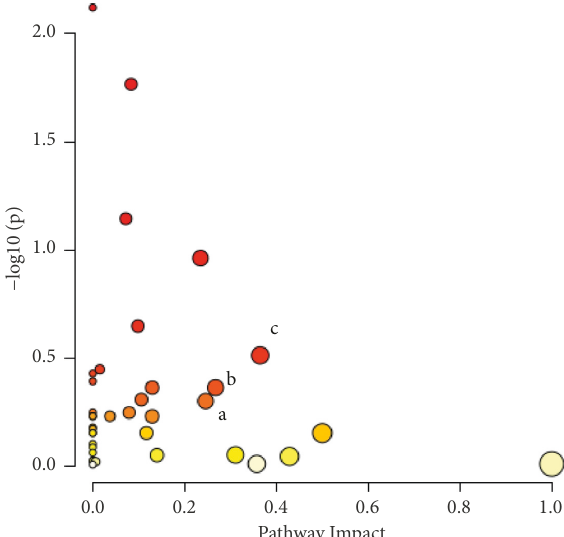
Figure 7: Summary of metabolic analysis conducted using MetaboAnalyst considering the 6 hours after treatment of Pt-EtOMe- SOphen vs. controls. (a) Glycine, serine, and threonine metabolism. (b) Pyruvate metabolism. (c) Glutathione metabolism. Colors, varying from yellow to red, mean that the metabolites are in the data with different levels of significance (yellow: p -value < 0.1; light orange: p -value < 0.05; orange: p -value < 0.01; and red: p -value < 0.001). Circle size, varying from small to big, means the impact of metabolites in data on the pathways alteration (small circle: low impact and large circle: high